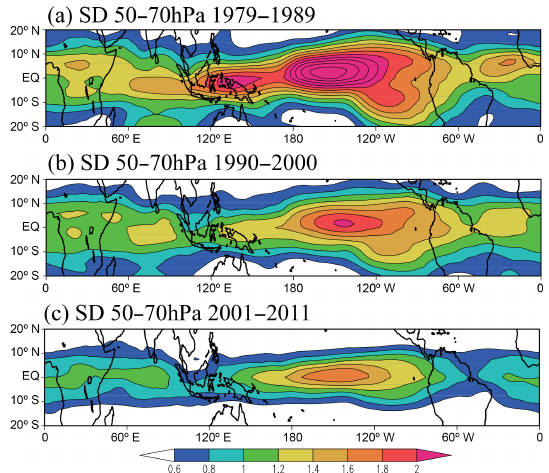
Figure 12. Standard deviation among four reanalyses (ERA-I, JRA- 25, JRA-55, and MERRA) at 50–70hPa for each 11-year mean: (a) 1979–1989, (b) 1990–2000, and (c) 2001–2011. The color in- tervals are 0.2ms − 1